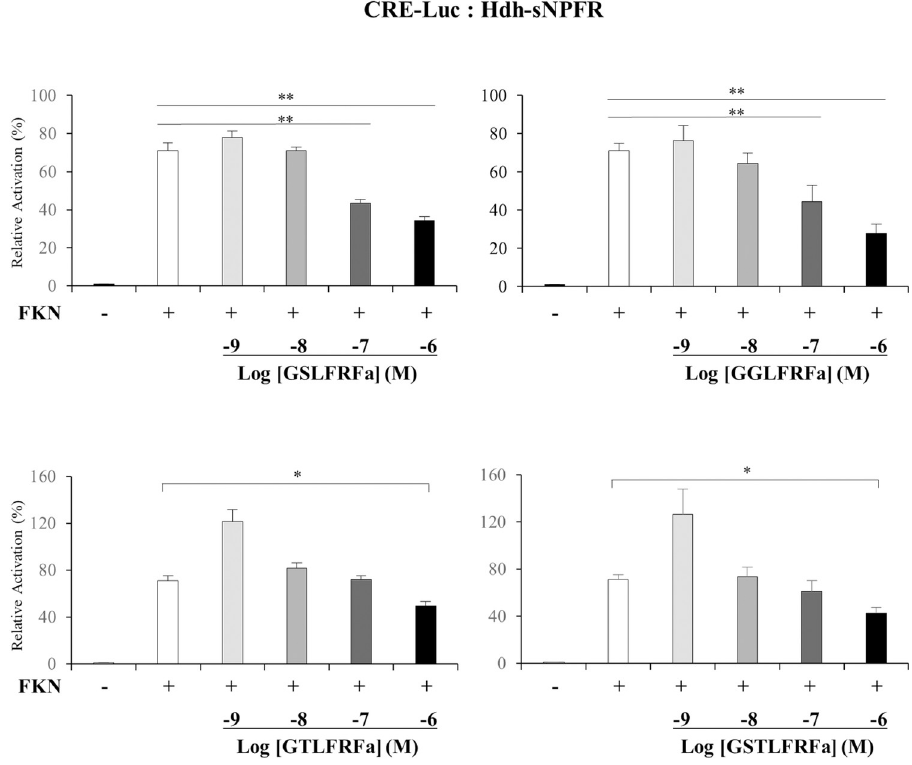
Fig 6. Effect of Hdh-LFRFa peptides on forskolin (FKN)-stimulated CRE-Luc activities in Hdh-sNPFR-expressing HEK293 cells. HEK293 cells were transiently transfected with Hdh-sNPFR, CRE-Luc reporter, and pRSV- β - galactosidase plasmids, and treated with FKN (10 − 5 M) and various doses of LFRFa peptides (10 − 9 –10 − 6 M), as described in the legend to Fig 5. All data represent the mean ± SEM (n = 3); � p < 0.05, �� p < 0.01.